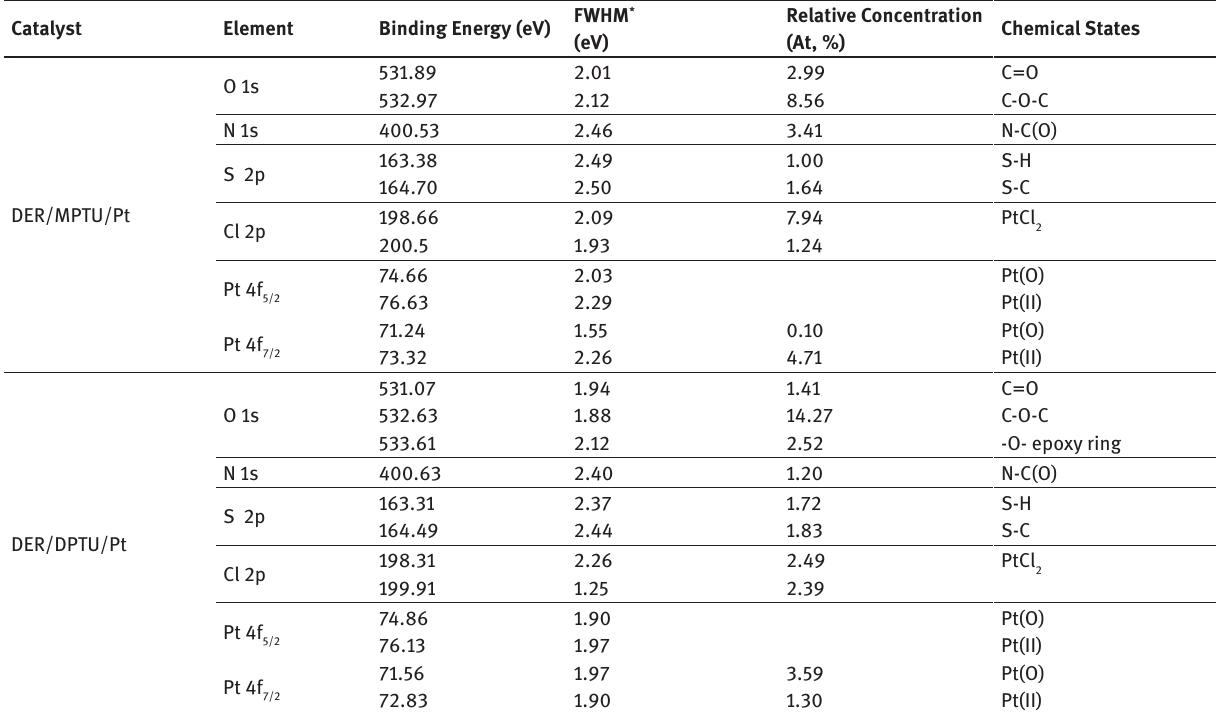
Table 1: Binding energy (eV) values from XPS measurements.